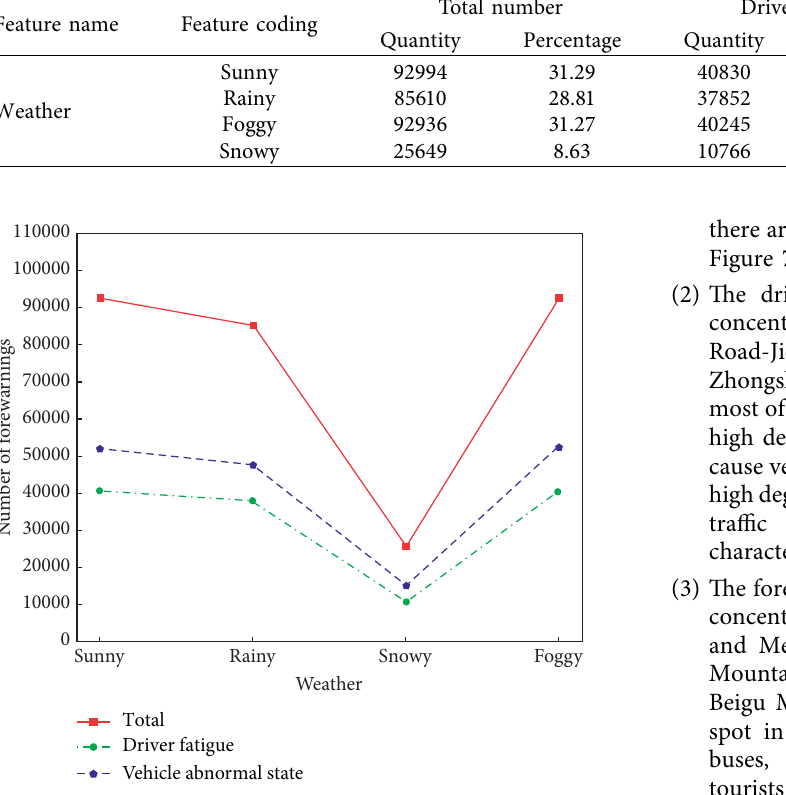
Figure 4: Distribution of forewarning types corresponding to different weathers.